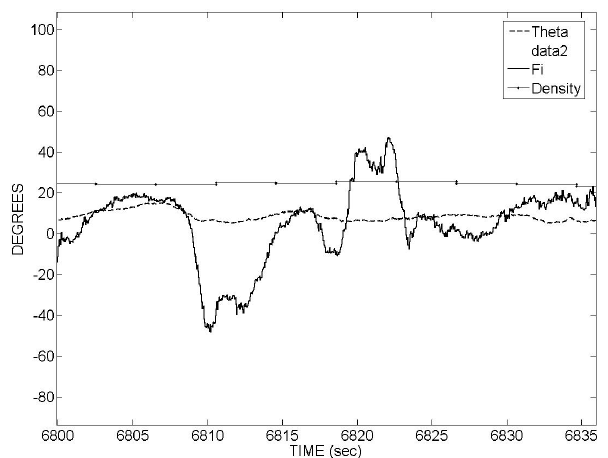
Fig. 2. Measurements of the ion number density (thin solid line with dots) along with the measurements of the polar angles ϕ , θ of the magnetic field vector. The direction of the magnetic field varies significantly during the time required to obtain a distribution